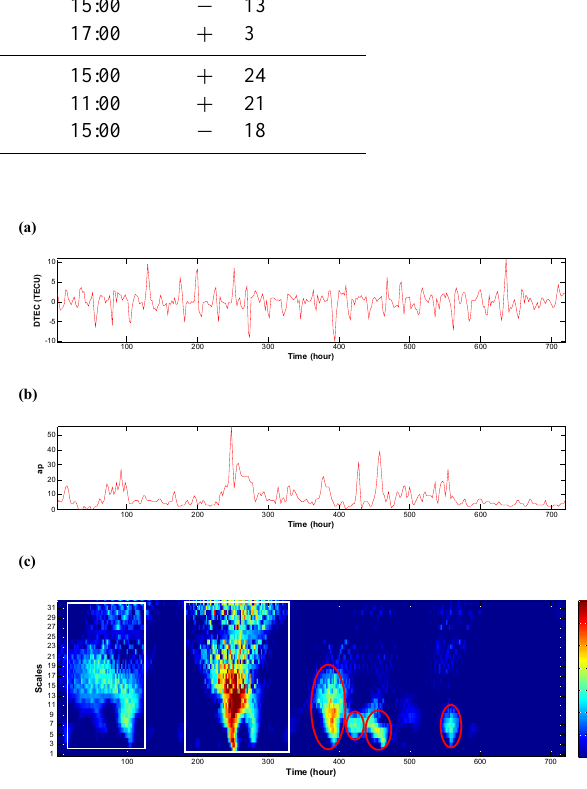
Figure 2. (a) The DTEC time series right over the epicenter (31.0° N, 103.4° E) of the Wenchuan earthquake from 13 April to 12 May, 2008. (b) The variations of the ap geomagnetic index from 13 April to 12 May, 2008. (c) The cross-wavelet spectrum for DTEC and ap using fbsp2-1-0.5 wavelet.